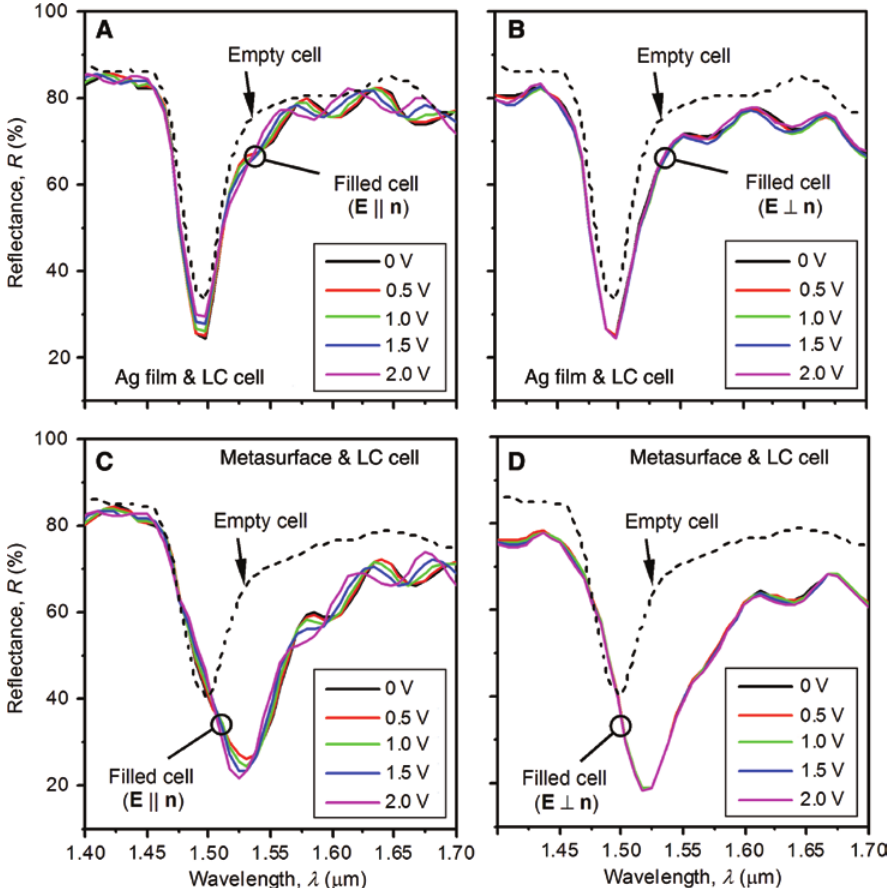
Figure 2: Experimental reflectivity spectra of the silver-coated Bragg mirror acquired with linearly polarized light at different voltages once the structure was integrated with a liquid-crystal cell (solid curves). Data in panels (A) and (B) correspond to an area of unpatterned silver film, while in panels (C) and (D) – to the metasurface. Dashed curves show the reflectivity spectra of the sample before the cell was filled with the